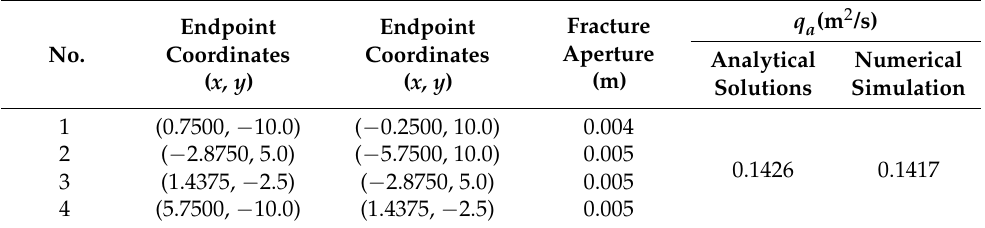
Table 4. Parameters for the intersecting fractures and downstream outlet flow